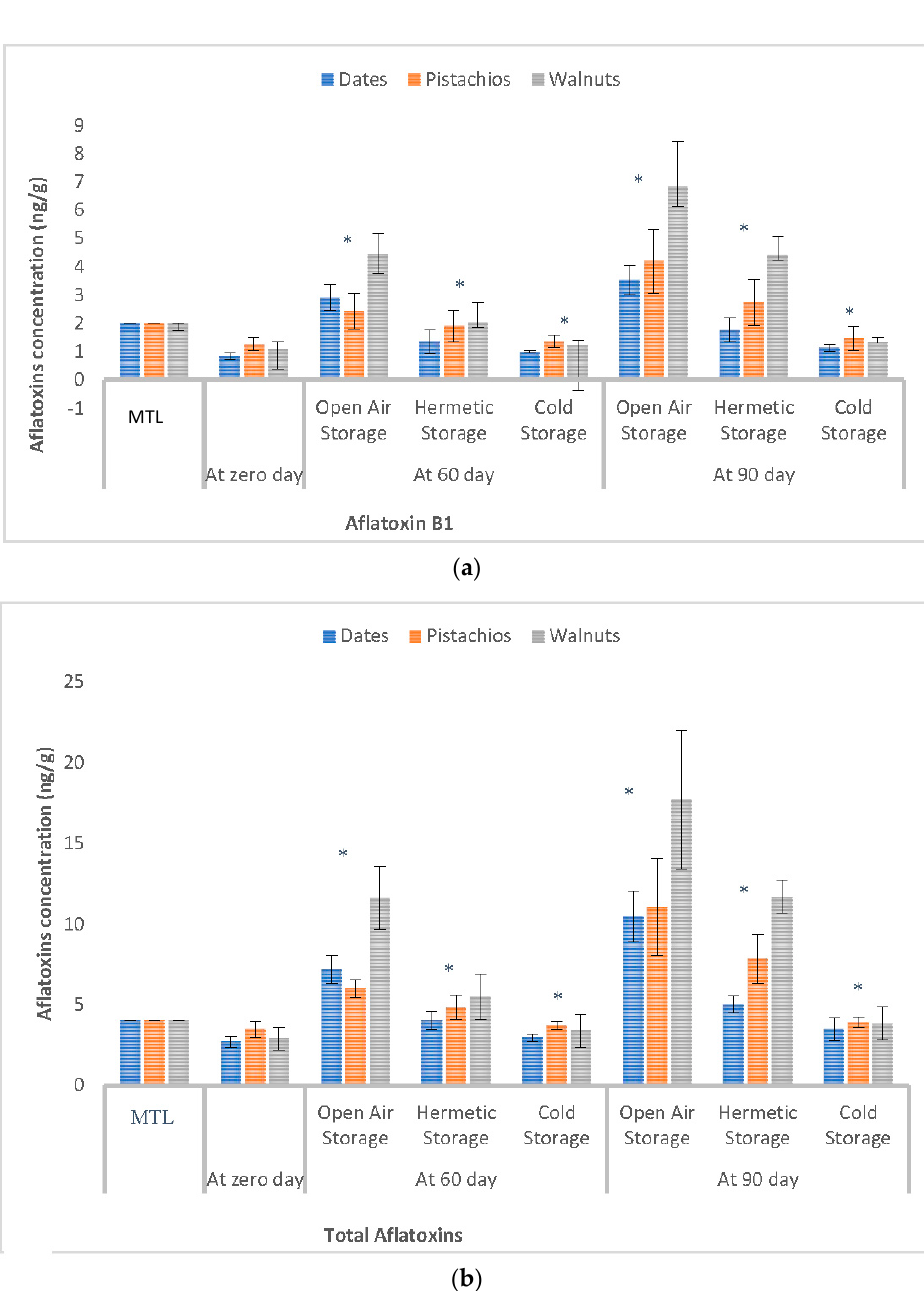
Figure 1. Concentrations (ng/g) of aflatoxin B 1 (AFB 1 ) ( a ) and total aflatoxins (AFT) ( b ) in dates, pistachios, and walnuts at 0 (zero), 60, and 90 days of storage under different conditions as compared with the statutory maximum tolerable levels (MTLs) of 2 ng/g for AFB 1 ( a ) and 4 ng/g for AFT ( b ) set by the European Union. An asterix mark (*) indicates statistically (<0.05) different concentrations from the control samples.